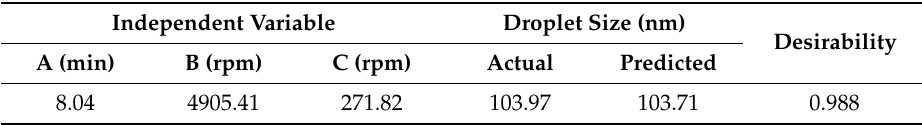
Table 6. Optimum formulation of KMO